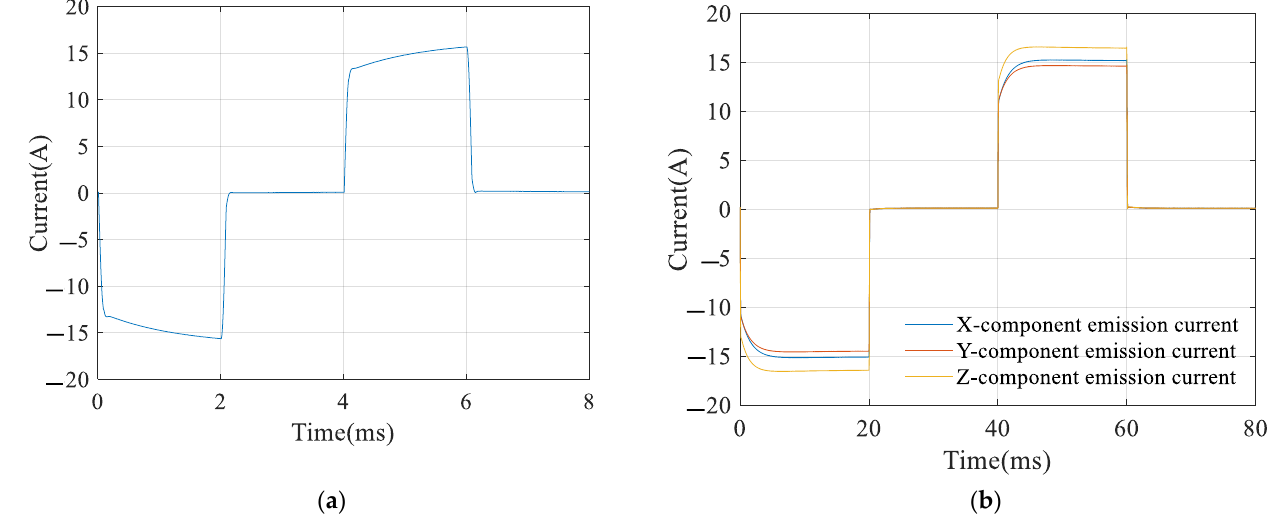
Figure 3. ( a ) Transmitting current in survey mode; ( b ) transmitting current in cued mode.